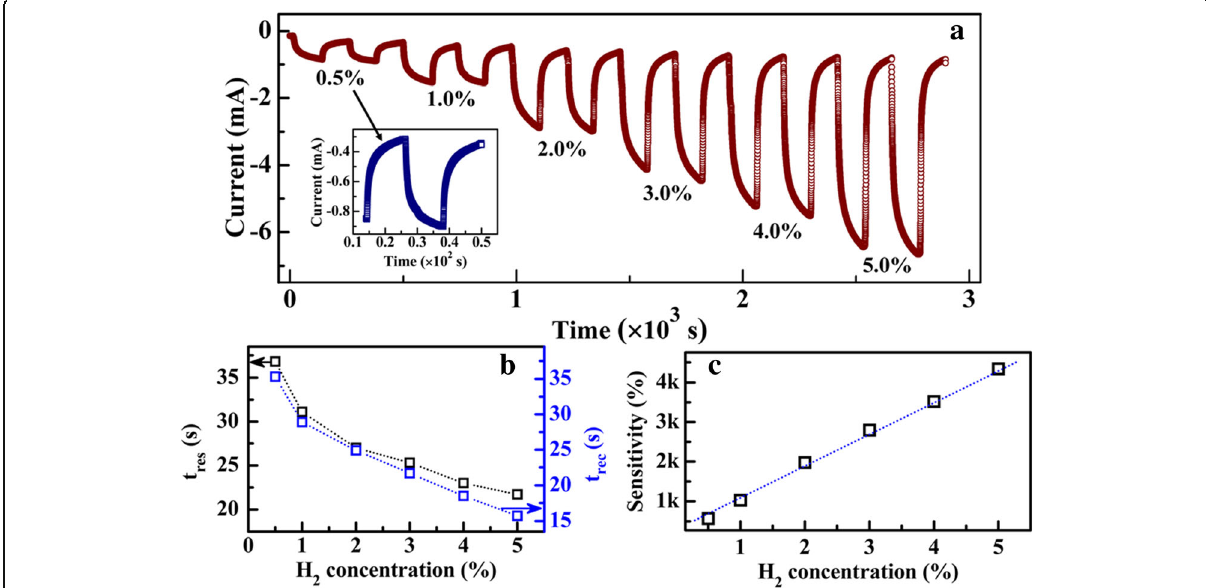
Fig. 6 a Dynamic responses of the Pd-decorated MoS 2 /Si heterojunction upon consequent H 2 at varying concentrations from 0.5 to 5% at − 1.0 V. The inset shows the enlarged image of the sensing characteristics of the heterojunction under H 2 of 0.5%. b Dependence of t res and t rec on H 2 concentration. c Dependence of the sensing response of the heterojunction on H 2